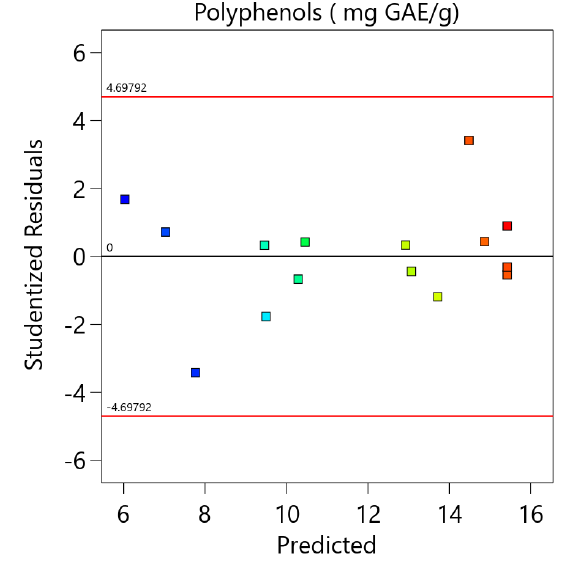
Figure A1. The comparison between the experimental and the predicted data and the residual analysis for the optimization of total phenolic content.